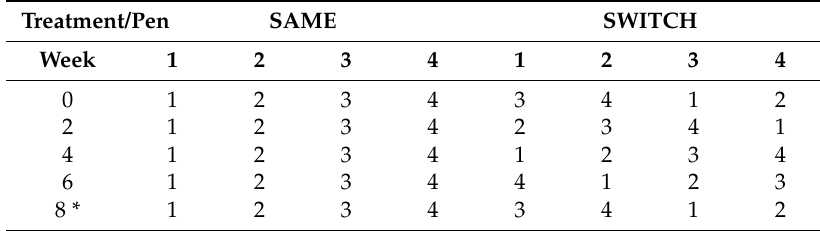
Table A1. The distribution of the enrichment combinations in each treatment group and pen. Treatment/Pen SAME